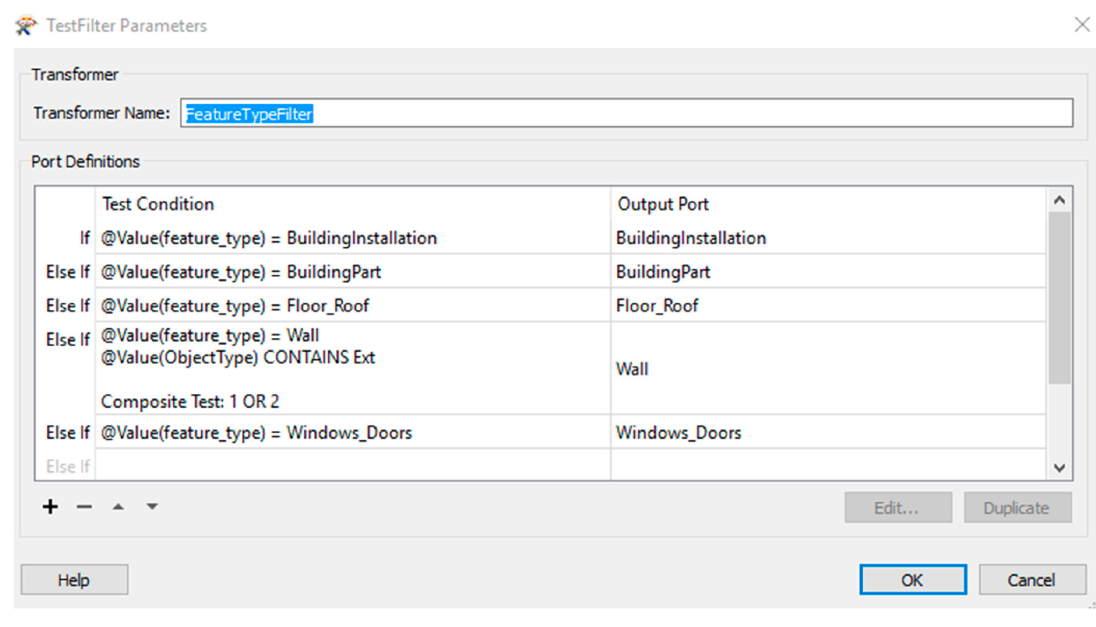
Figure 9. TestFilter Parameters for CityGML attributes.